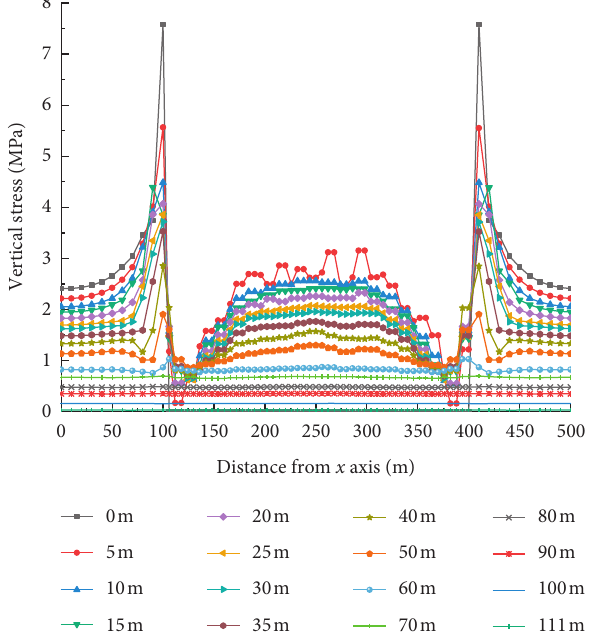
Figure 12: Distribution of vertical stress on inclination observation